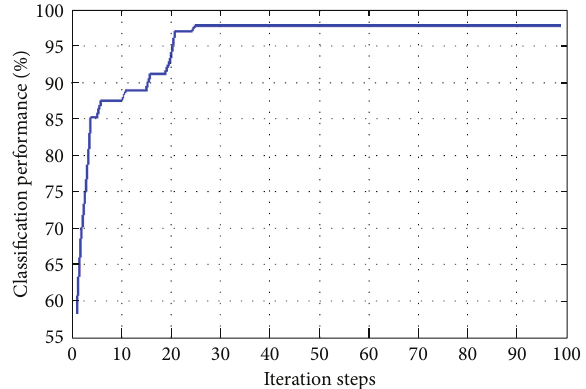
Figure 3: A test result for iris